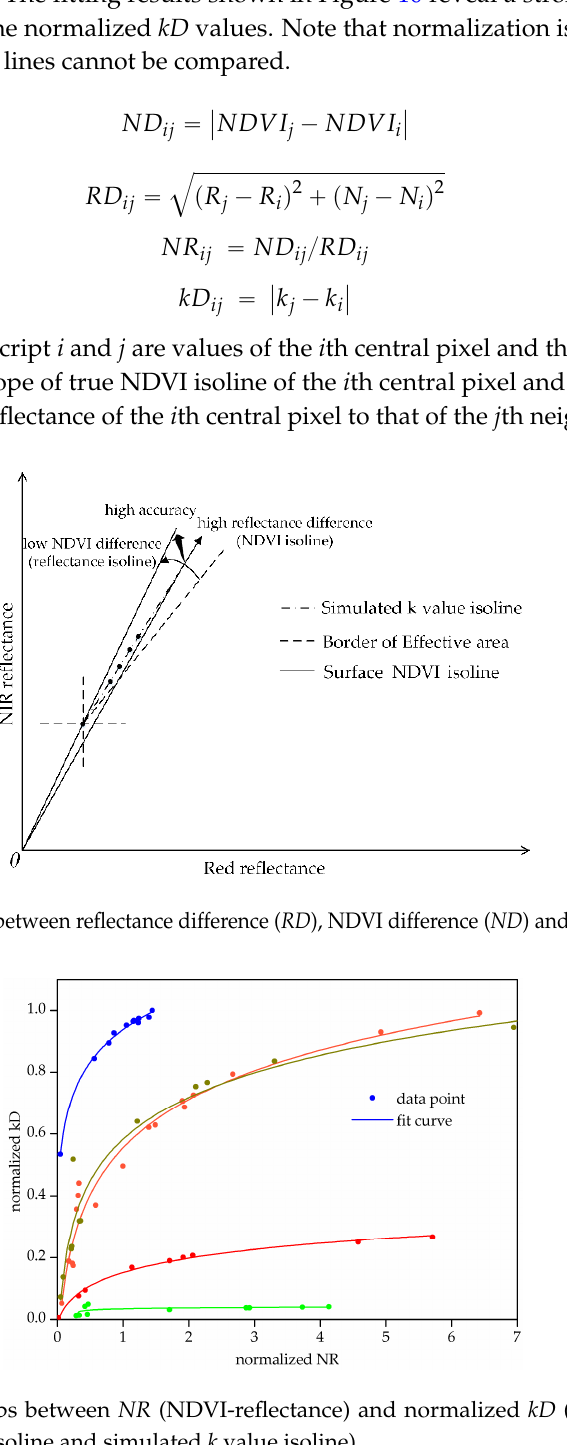
Remote Sens. 2016 , 8 , 489